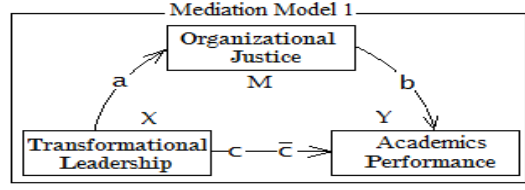
Figure 2. Mediation Model 1. Table 5. Model Summary (path-a).